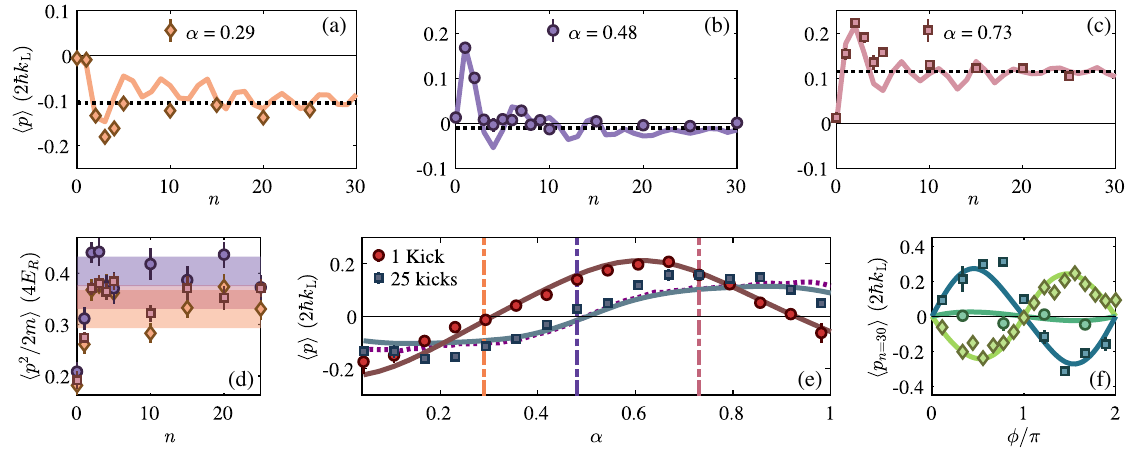
FIG. 2. Characterization of the quantum boomerang effect. All error bars show standard error of the mean on repeated measurements. (a) – (c) Average momentum vs kick number for V 0 ¼ 41 E and T ¼ 8 μ s, at α ¼ 0 . 29 , 0.48, and 0.73, respectively. Solid curves show R numerical predictions. Dotted lines show infinite-time average momenta predicted by the Floquet diagonal ensemble [Eq. (A5)]. Note that ϕ ¼ 0 . 9 π = 2 for all experimental runs. (d) Measured energy vs kick number for all three values of α . Shaded areas indicate long-term energy by averaging data points between 10 and 25 kicks. (e) Measured average momentum after 1 kick (red circles) and 25 kicks (blue squares) vs α for the same experimental parameters. Same-color solid lines show numerical predictions. Dashed vertical lines indicate α in panels (a) – (c). The dotted purple line shows the prediction of the Floquet diagonal ensemble [13]. (f) Average momentum after 30 kicks vs ϕ for V 0 ¼ 70 E , T ¼ 7 μ s, and α ¼ 0 . 15 (diamonds), 0.48 (circles), and 1.05 R